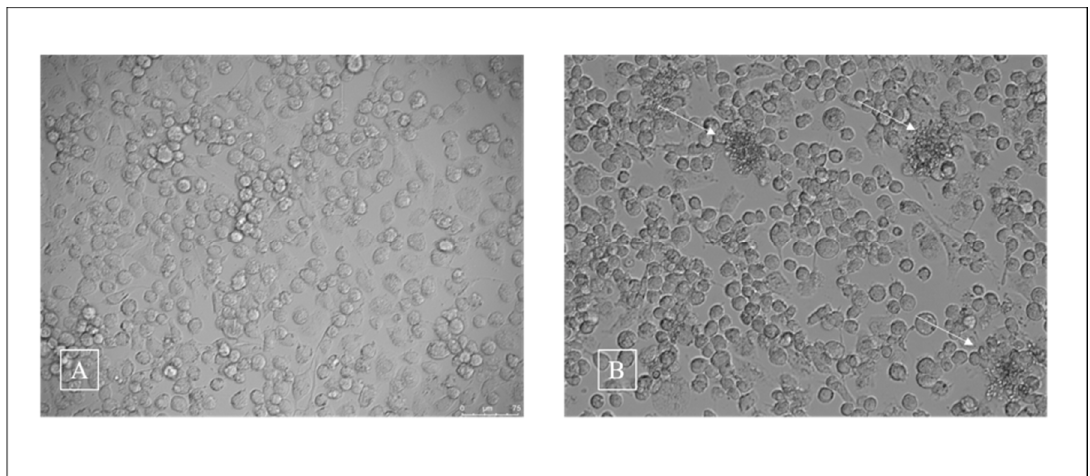
Figure 3. Co-culture of inactivated Trichophyton rubrum microconidia with THP-1 cells for 24 h. ( A ): THP-1 cell line (magnification 400 × ). ( B ): Co-culture. The arrows indicate fungal elements in contact with macrophages (magnification 400 × ).